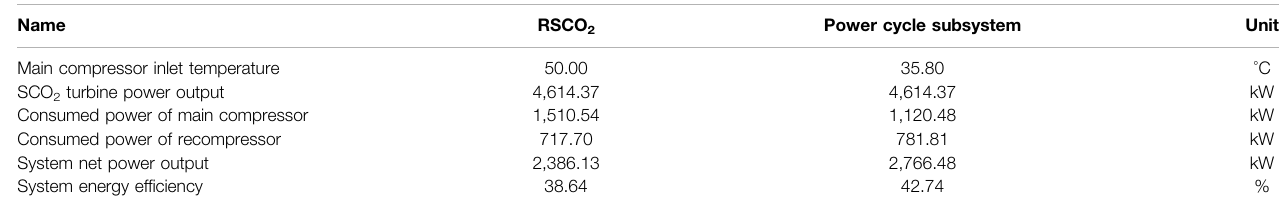
TABLE 7 | System performance comparison between power cycle subsystem and stand-alone RSCO 2